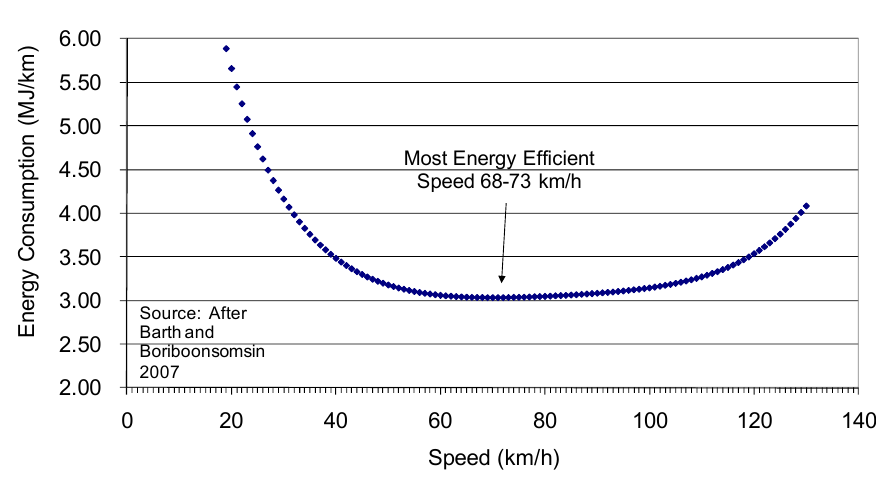
Figure 1. Energy Consumption Impact of Different Traffic Speeds.